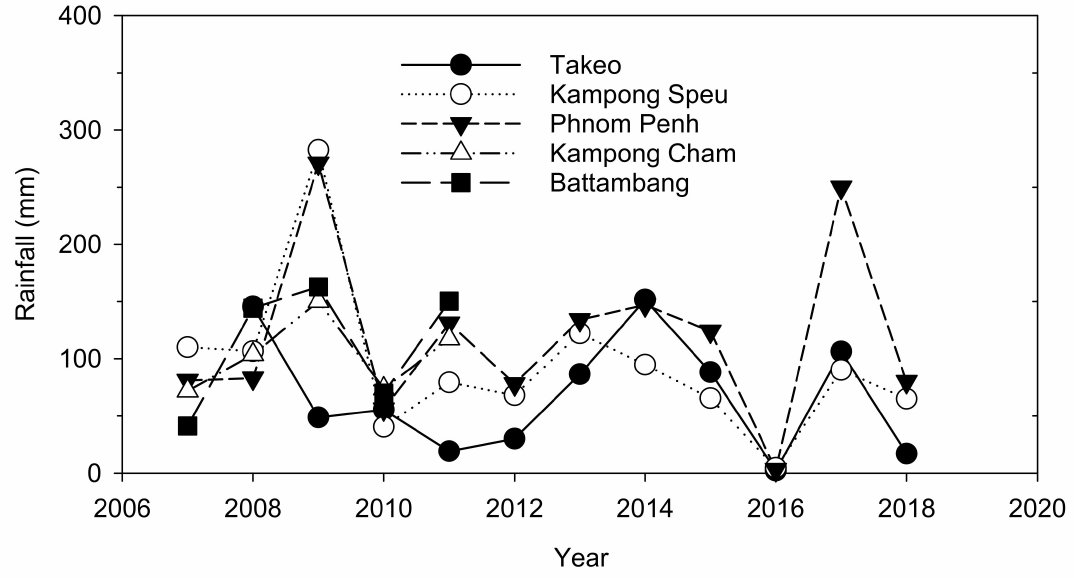
Figure 5. Total rainfall (mm) in April (early wet season) at Takeo, Kampong Speu, Phnom Penh Kampong Cham and Battambang over the period 2007–2018. Source: Department of Meteorology, Cambodia. Note: rainfall records are incomplete which accounts for missing